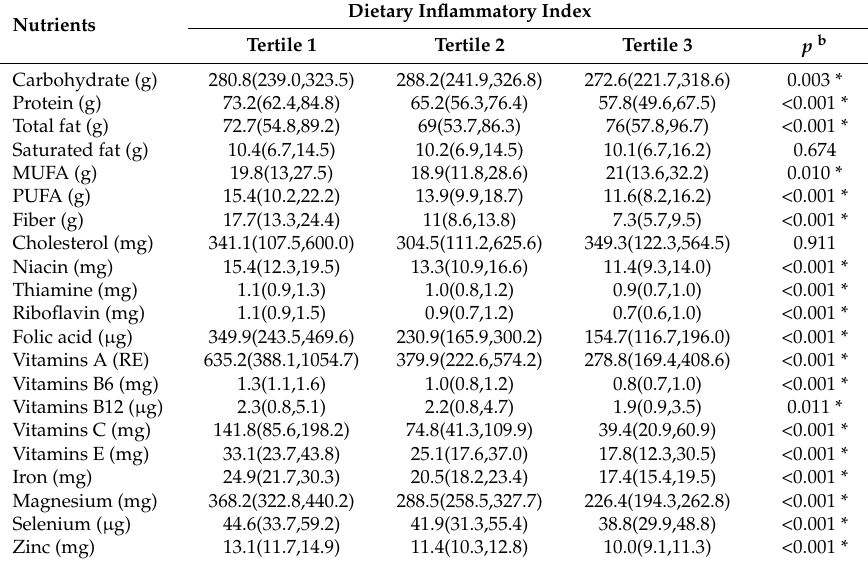
Table 2. Nutrients intakes of tertiles of the DII, P50th (P25th, P75th) a .